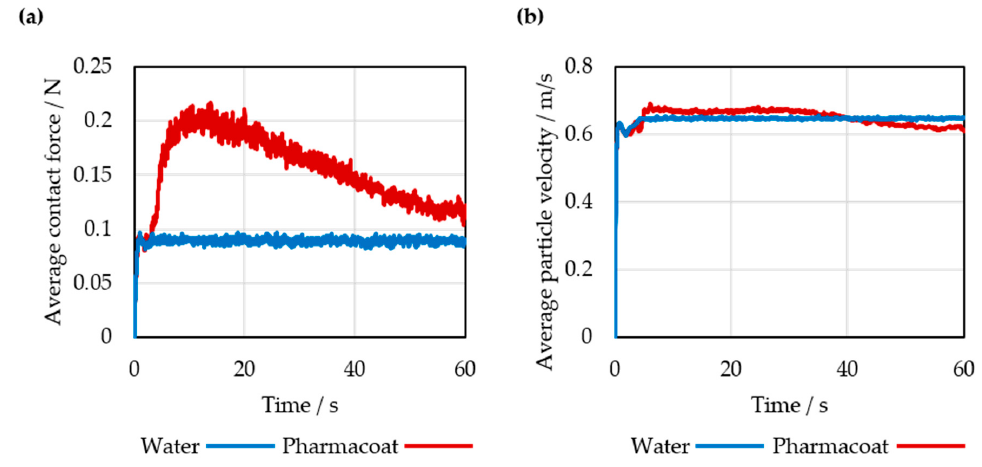
Figure 10. Average particle velocity ( a ) and average contact force acting on the particle ( b ) for the double water injection case III, and the Pharmacoat 606 case IV.